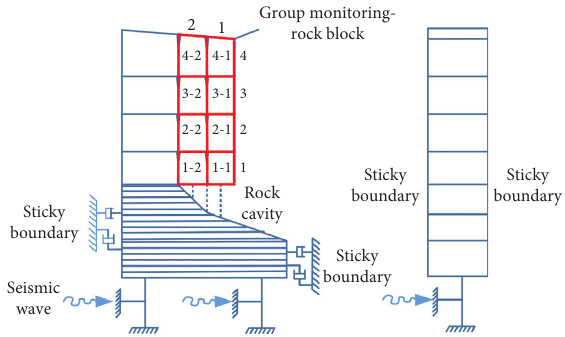
Figure 17: Boundary conditions for the dynamic